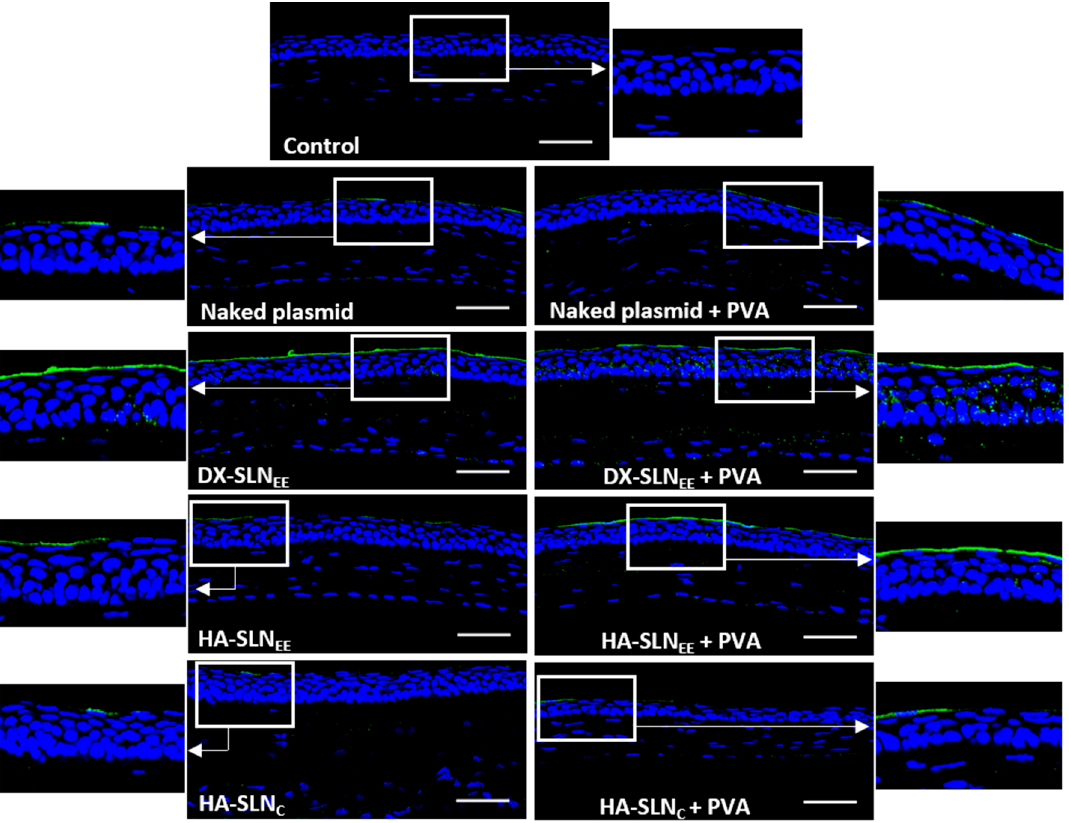
Figure 6. Corneal transfection in vivo in wild type mice treated with naked plasmid and vectors bearing the plasmid pcDNA3-EGFP with and without PVA (20×). Blue: nuclei stained with DAPI. Green: green fluorescent protein. Scale bar: 50 µm. DX: dextran; SLN: solid lipid nanoparticle; PVA: polyvinyl alcohol; HA: hyaluronic acid.